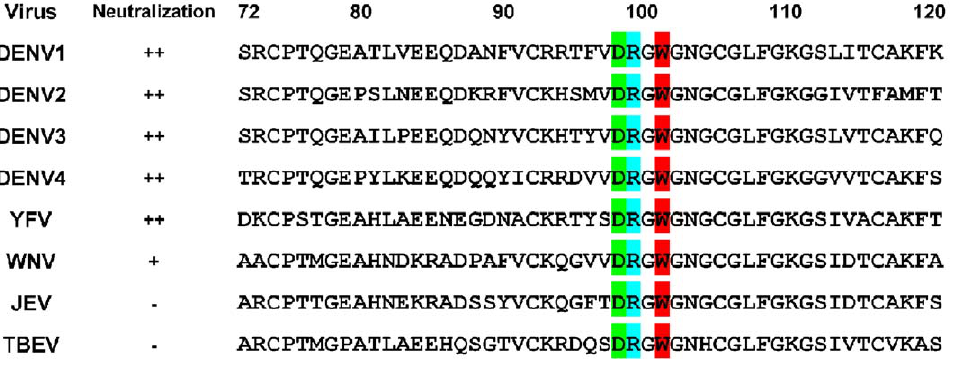
Figure 2. Comparison of the amino acid sequences of flavivirus E proteins. Amino acids at positions 72 to 120 are shown. Boxed residues indicate that positions 98 (green), 99 (blue), and 101 (red) were highly conserved among the flaviviruses examined and constitute a conformational